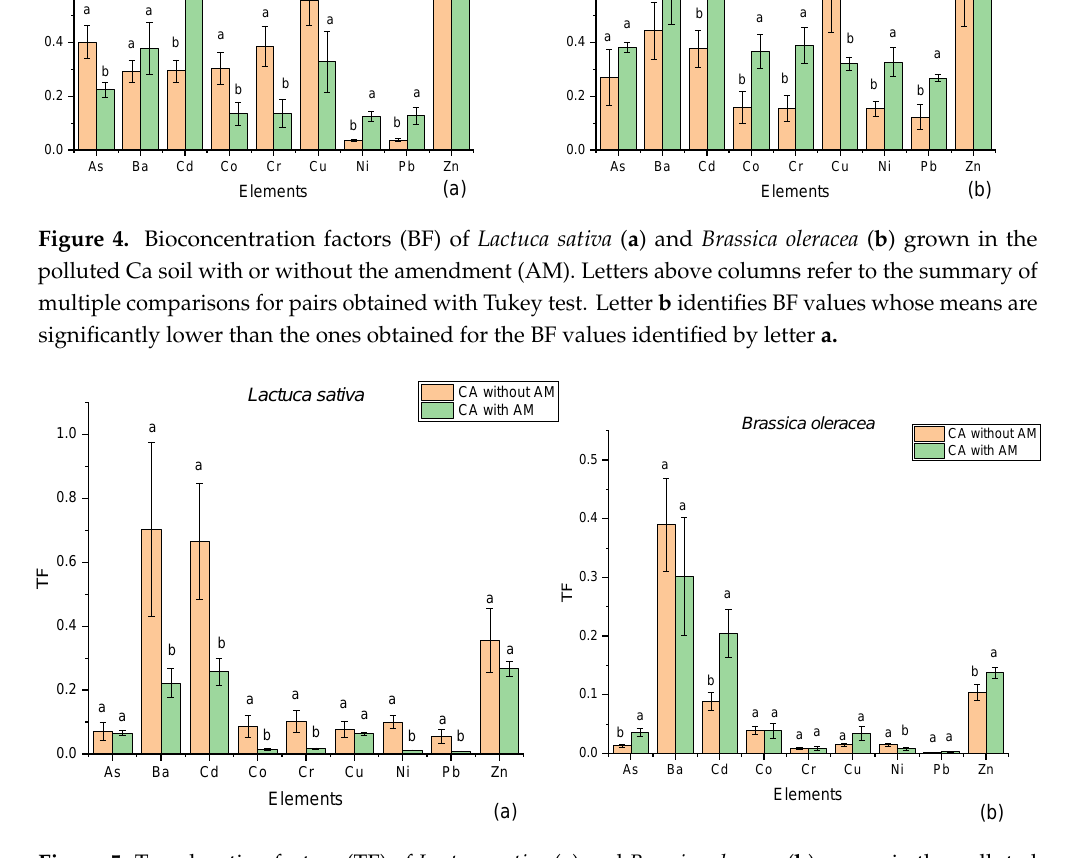
Figure 5. Translocation factors (TF) of Lactuca sativa ( a ) and Brassica oleracea ( b ) grown in the polluted CA soil with or without the amendment (AM). Letters above columns refer to the summary of multiple comparisons for pairs obtained with Tukey test. Letter b identifies TF values whose means are significantly lower than the ones obtained for the TF values identified by letter a.